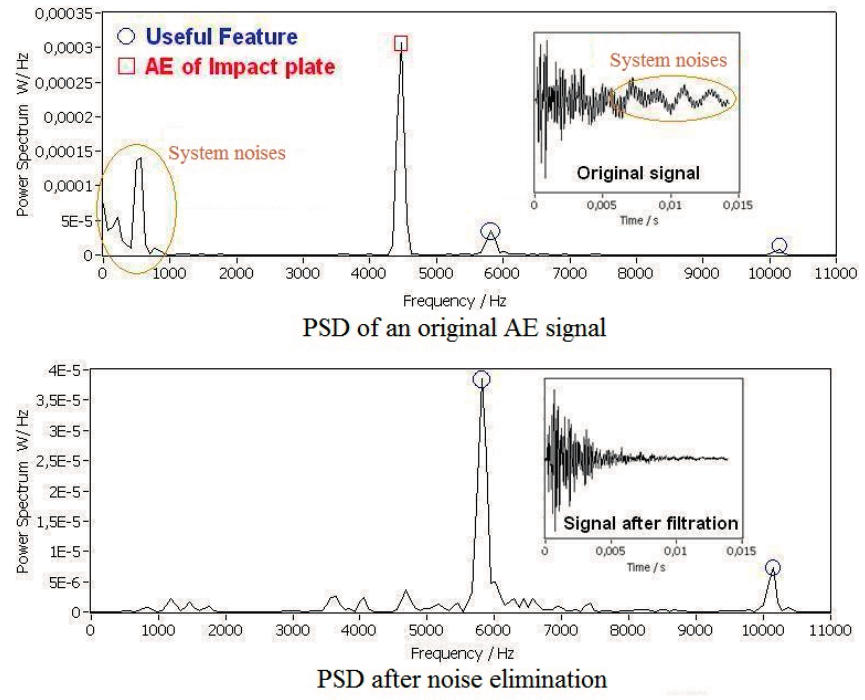
Figure 3. Power spectrum density (PSD) spectrum of an impact AE signal before and after